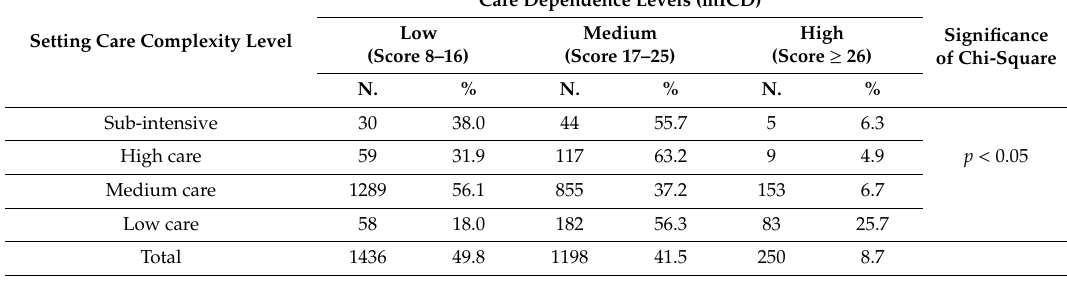
Table 8. Distribution of levels of care dependence by setting care.